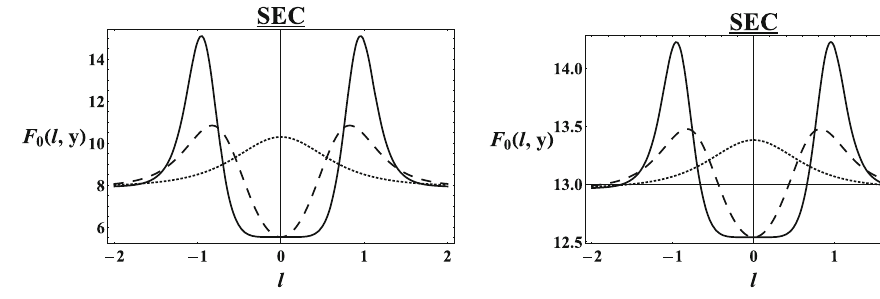
> 0 (where f ( y ) = − log [ cosh ( y ) ] ) for m = 2 , 4 , 8 0